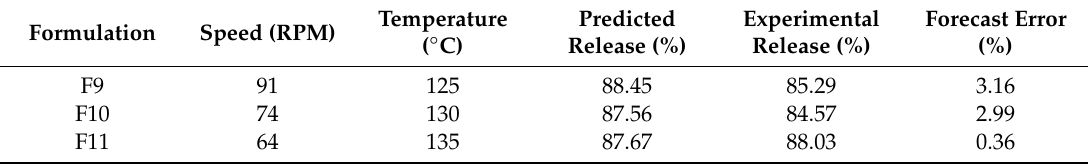
Table 5. Optimize formulations (release at 30 min).